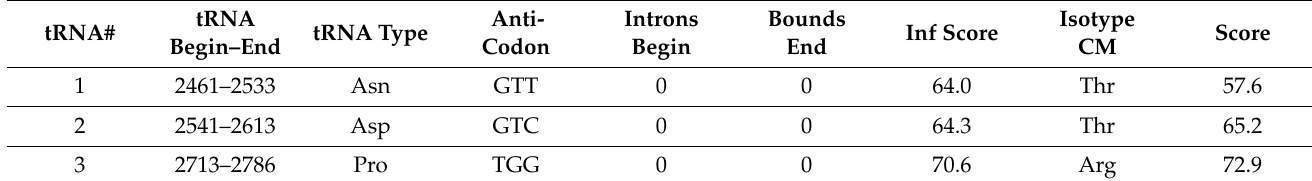
Table 3. Genomic characteristics of the predicted